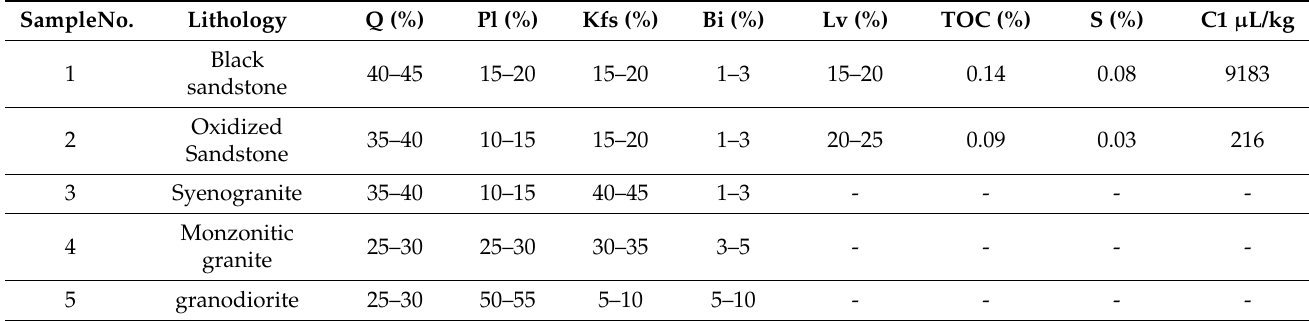
Table 3. Average mineral and organic matter content of Sifangtai Formation sandstones and Zhang Guangcailing- Xiaoxinganling